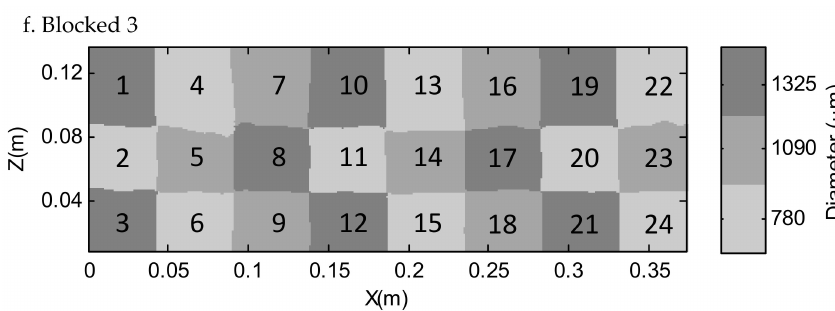
Figure 2. Bead size distribution for the layered ( a – c ) and blocked ( d – f ) heterogeneous configura- tions. The grayscale colourmap represents bead diameter, and the numbers identify the individual permeability zones for